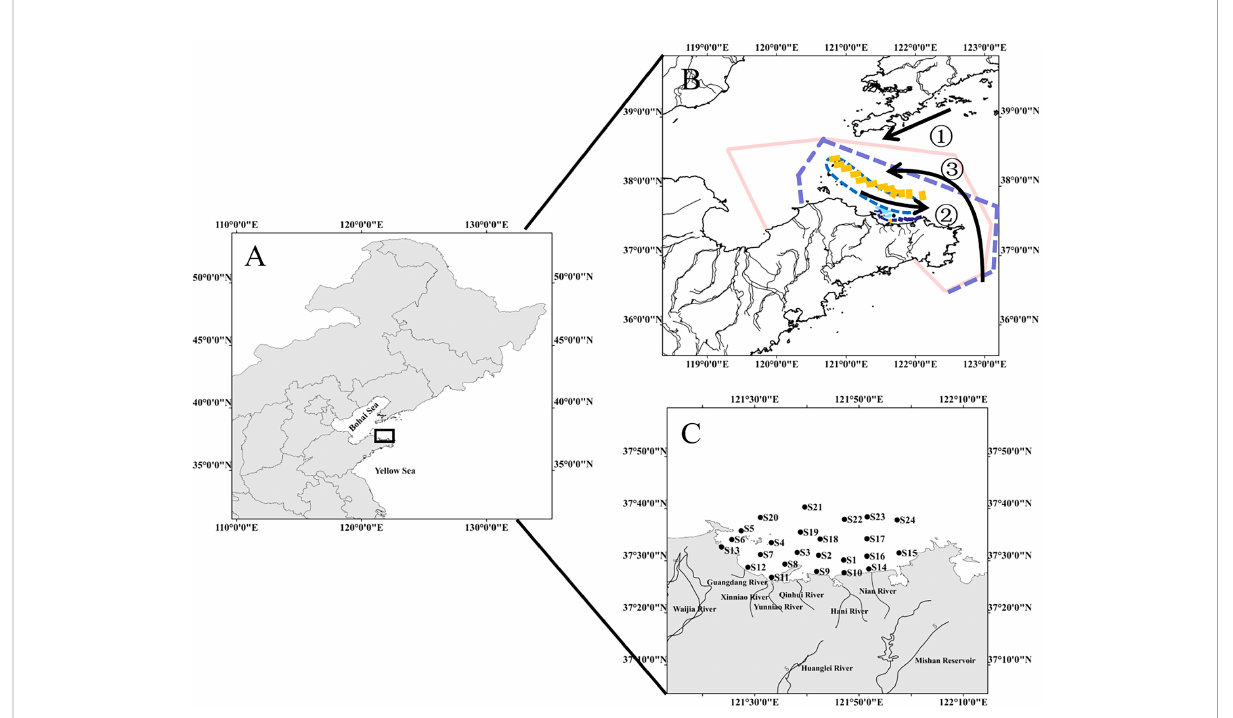
FIGURE 1 (A) Map of the study area, (B) Schematic diagram of the spatial layout of the Yantai Sishili Bay Marine Ranch and (C) Sampling sites in the YOA, China. In Figure B the colored lines represent a schematic diagram of the spatial layout of the Yantai Sishili Bay Marine Ranch and its surrounds: The orange line represents the offshore recreational sea fi shing belt, the dark blue line indicates the coastal sightseeing fi shery belt; the pink line represents the bottom sowing area of sea treasures in the northeastern peninsula; the purple dotted lines represent the main area of arti fi cial reef construction in Jiaodong Peninsula; the blue dotted line represents the Yanwei offshore shell fi sh ecological park; the light blue line represents the marine ranch prohibited development zone. Marine dumping area in Yantai area in 2019: Dark spot represents the temporary dumping area; and the orange spot shows the formal dumping area. The major sea currents include ① Liaonan Coastal Current; ② Lubei Coastal Current; ③ Yellow Sea Warm